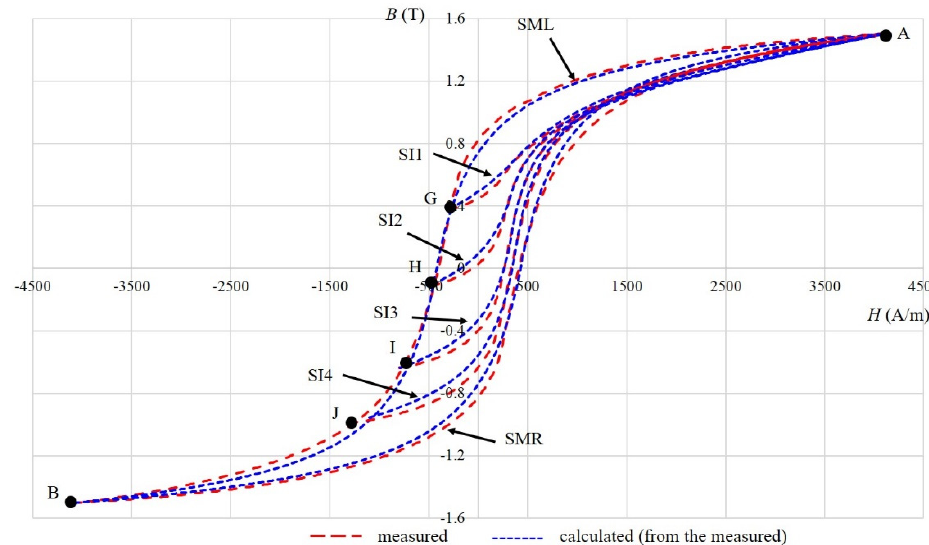
Figure 10. Measured and calculated major hysteresis loop (SML and SMR) and first-order increasing reversal curves (SI1–SI4).